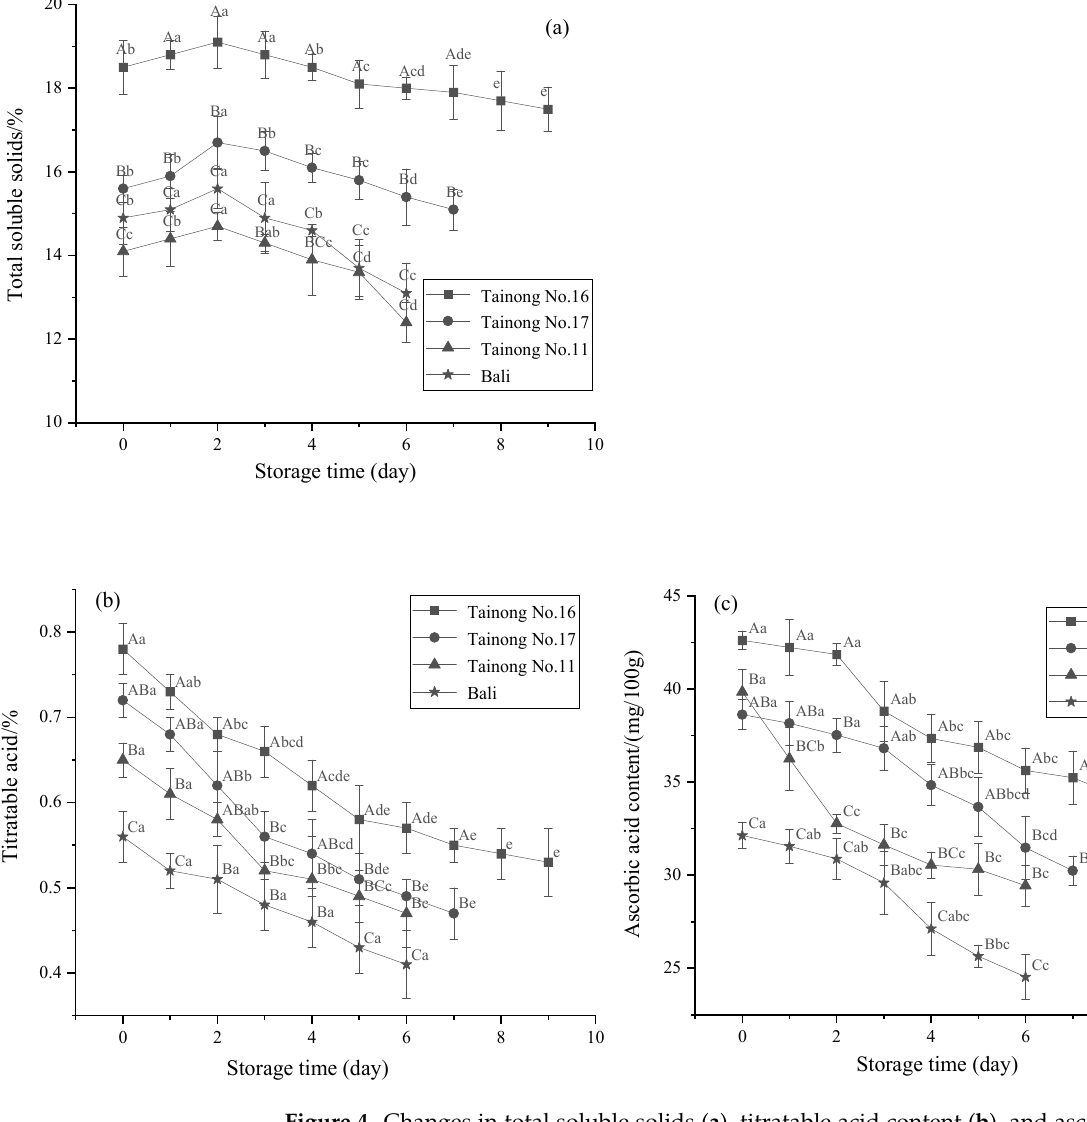
Figure 4. Changes in total soluble solids ( a ), titratable acid content ( b ), and ascorbic acid content ( c ) in freshly cut pineapple during storage. Different capital letters (A–C) indicate significant ( p < 0.05) differences in total soluble solids, titratable acid content, and ascorbic acid content between varieties at the same storage time; different lowercase letters (a–e) indicate significant ( p < 0.05) differences in total soluble solids, titratable acid content, and ascorbic acid content between the same varieties at different storage times.